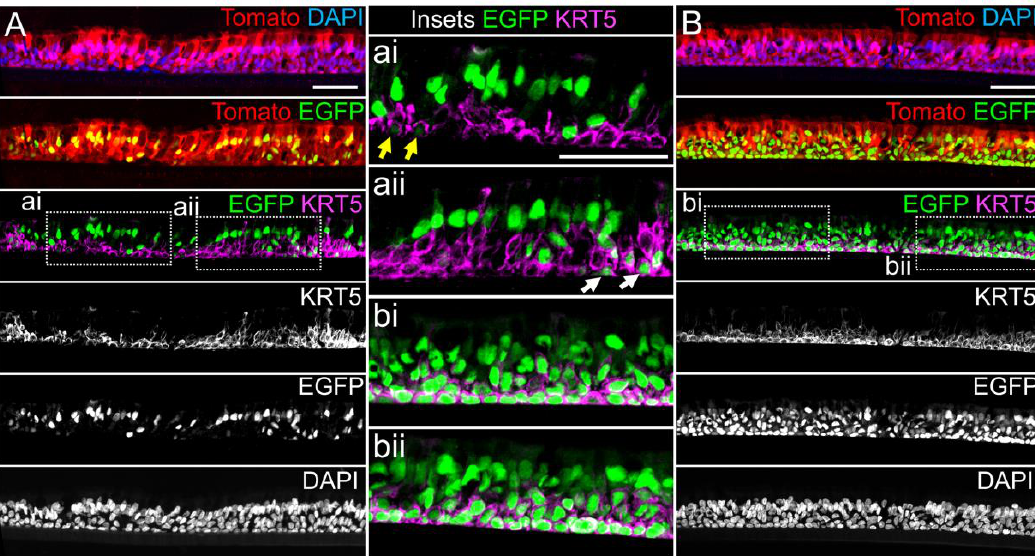
Figure 4. Lentiviral-mediated basal cell detargeting of EGFP following differentiation at an air–liquid interface. Primary human basal cells were transduced with LV-dt/EGFP-miRT or LV-dt/EGFP-RmiRT vectors and expanded for 1–2 days before seeding for differentiation in air–liquid interface (ALI) cultures. ( A,B ) Confocal microscopic images of ( A ) LV-dt/EGFP-miRT and ( B ) LV-dt/EGFP-RmiRT transduced ALI culture using sections immunostained for KRT5 (keratin-5) and imaged for KRT5, EGFP, and Tomato expression with DAPI to mark nuclei. Dual and single channel images are shown. Enlarged boxed regions in ( A , B ) are shown in the middle column. Scale bar, 50 µ